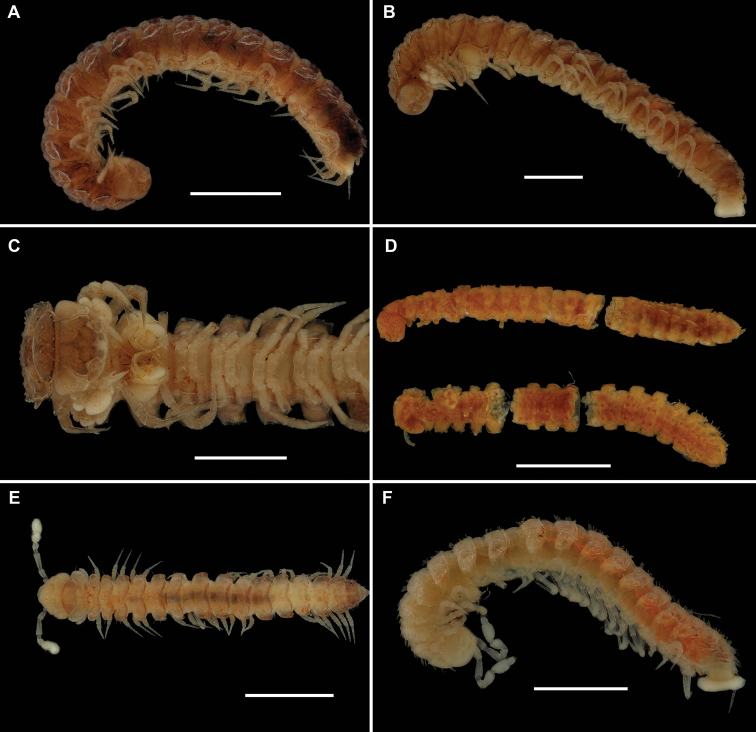
Habituses of APhysetoparia
complexa sp. nov., ♂ holotype, lateral view B, CBactrodesmus
grandis sp. nov., ♂ paratype, lateral view of entire animal and its anterior body half, ventral view DHemisphaeroparia
parvula (Porat, 1894), both ♀ syntypes, lateral, subventral or sublateral view EHemisphaeroparia
longibrachiata sp. nov., ♂ holotype, dorsal view FHemisphaeroparia
avis sp. nov., ♂ paratype, lateral view. Scale bars: 1.0 mm.